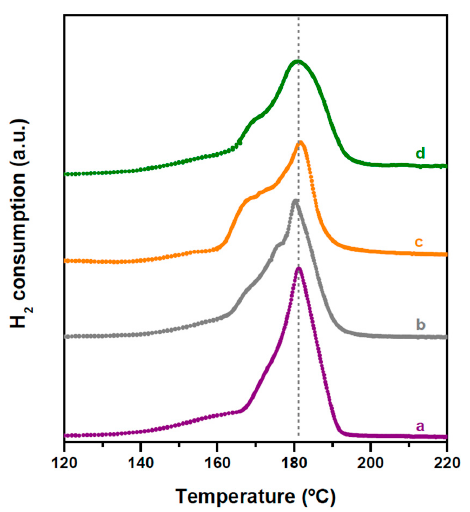
Figure 8. Temperature-programmed reduction (TPR) profiles of pristine CZA (a) and CZA-xHPW/Ti hybrid catalysts: CZA-1.4HPW/Ti (b), CZA-1.7HPW/Ti (c) and CZA-2.7HPW/Ti (d). XRD profiles of reduced CZA-HPW/Ti hybrid catalysts are depicted in Figure 9. All reduced hybrid catalysts show diffraction peaks corresponding to reflections of metallic Cu (43.0 and 50.2°